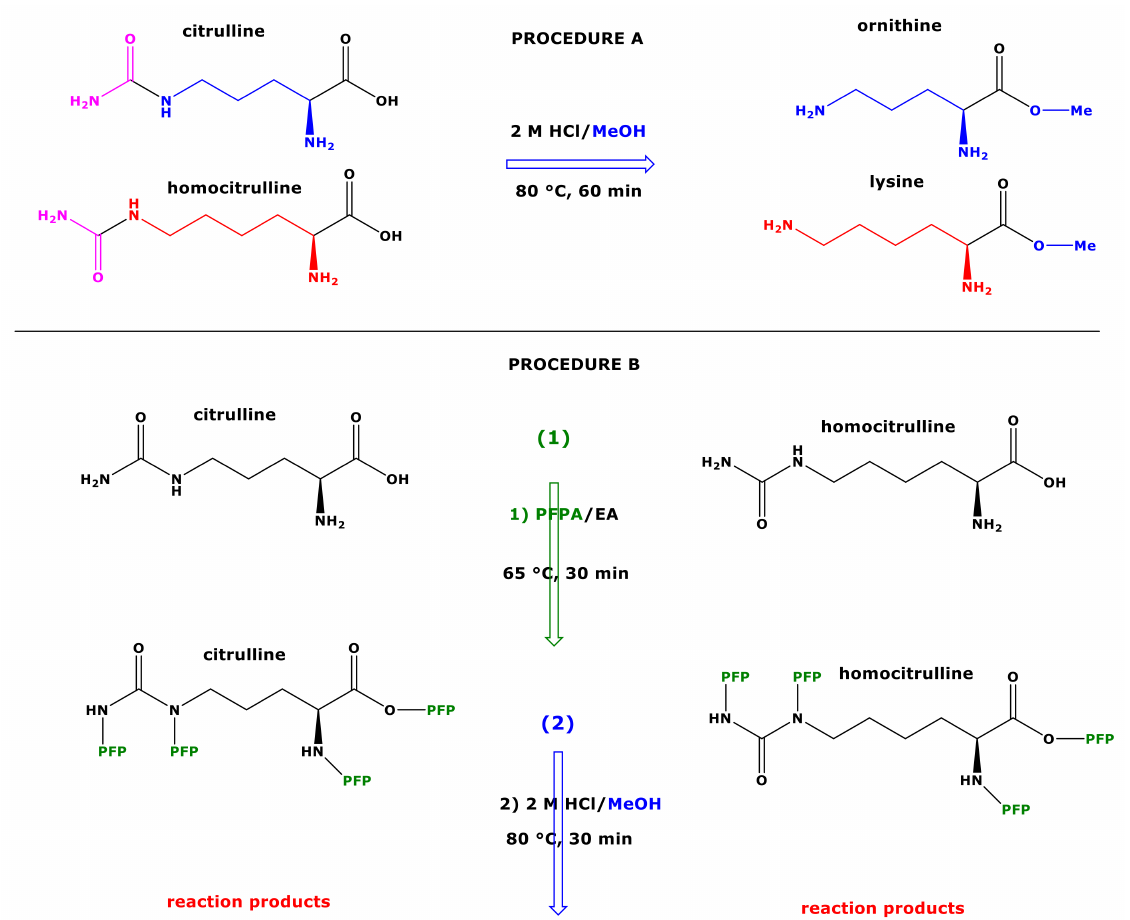
Figure 1. Upper panel, procedure ( A ) Schematic of the reactions of citrulline and homocitrulline with 2 M HCl/MeOH forming the methyl esters of ornithine and lysine, respectively. Lower panel, procedure ( B ) Schematic of the two-step derivatization of citrulline (left) and homocitrulline (right) first with PFPA/EA to form their PFP derivatives with the proposed formulas Cit-(PFP) 4 and hCit-(PFP) 4 , respectively. Subsequently, these derivatives react with 2 M HCl/MeOH (procedure B) to form reaction products that were characterized structurally by GC-MS in the present study. Cit, citrulline; hCit, homocitrulline; MeOH, methanol; PFPA, pentafluoropropionic anhydride; PFP, pentafluoropropionyl residue; EA, ethyl